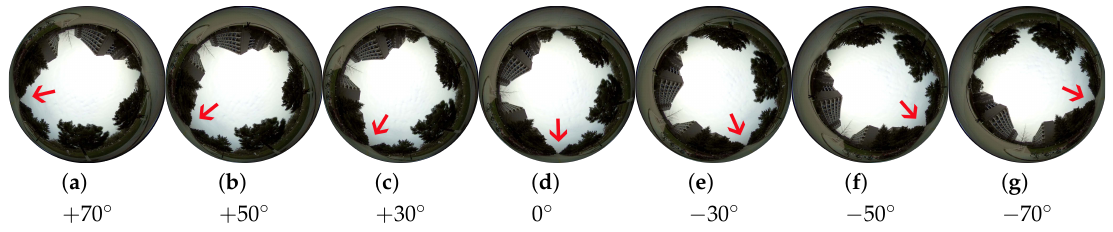
Figure 3. Sample images when an upward-facing spherical camera rotates. The central bottom pixels are the current heading direction of the robot platform and the red arrows represent one specific potential direction. The azimuth rotations of the robot platform merely lead to corresponding 2-dimensional rotations of the spherical